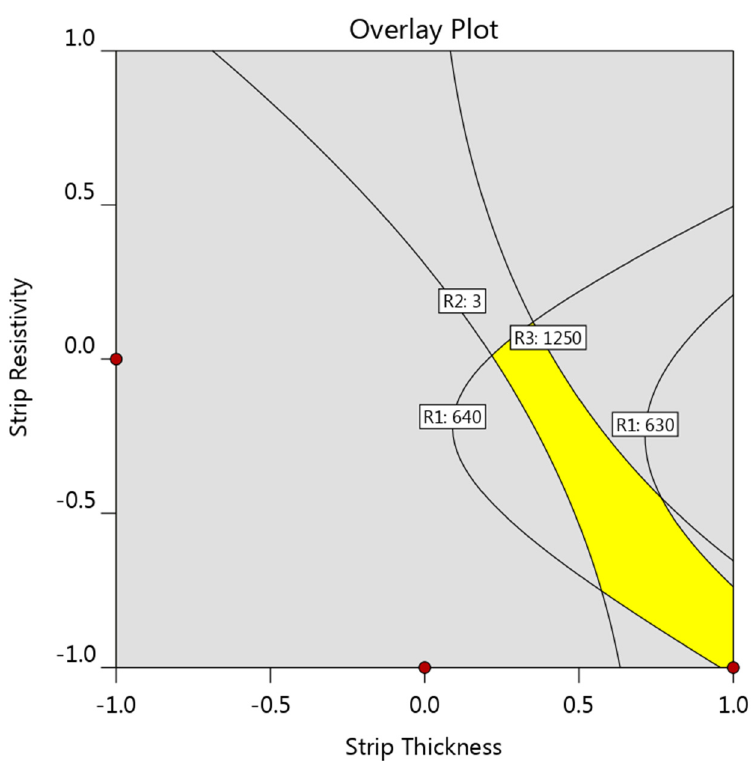
Figure 14. Overlay plot showing the preferable strip properties for a 0.40 mm thick steel.